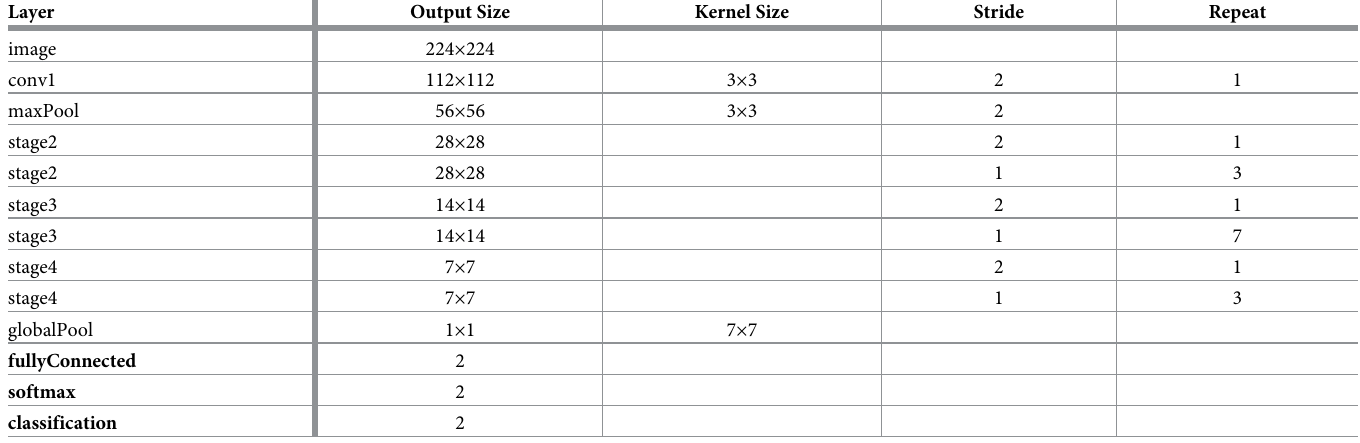
Table 1. ShuffleNet